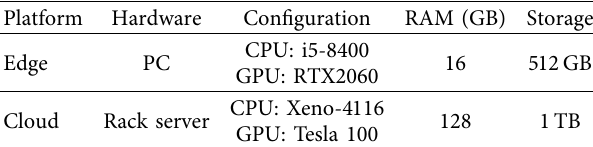
Table 1: Hardware parameters of edge nodes and cloud servers. Platform